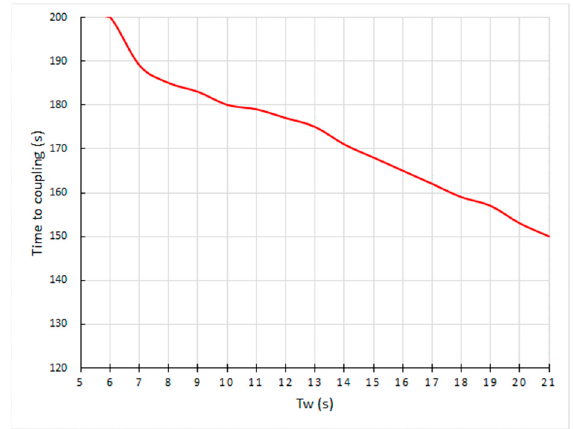
Figure 10. Time to coupling depending on the Tw state.